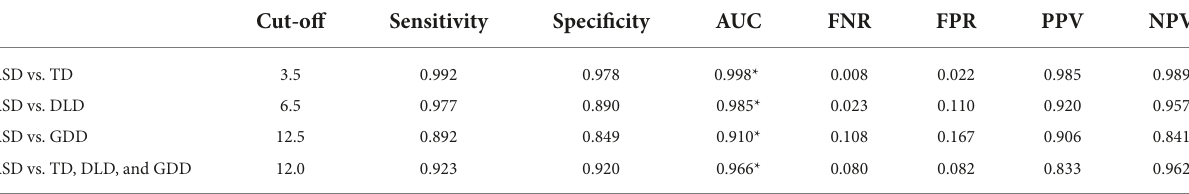
TABLE 4 Cutoff score, sensitivity, specificity, AUC, FNR, FEP, PPV, and NPV based on ROC curve analysis to discriminate ASD and TD control, as well as ASD and non-ASD clinical groups. Cut-off Sensitivity Specificity AUC NPV ASD vs. TD